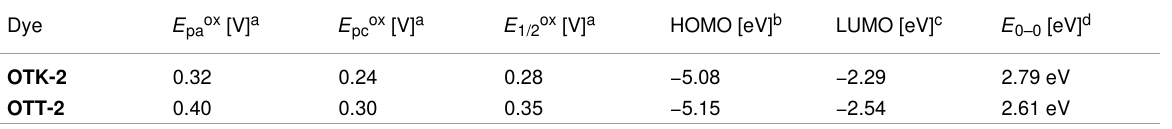
Table 3: Electrochemical data, and HOMO and LUMO energy levels of OTK-2 and OTT-2 .